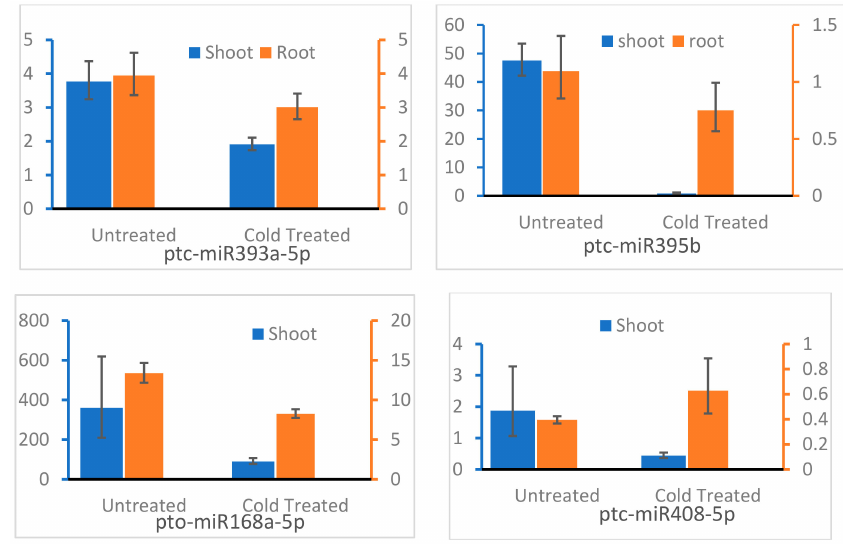
Figure 6. Relative expression analysis of candidate miRNAs in shoot and root of Populus simonii × P. nigra with and without cold treatment by real time